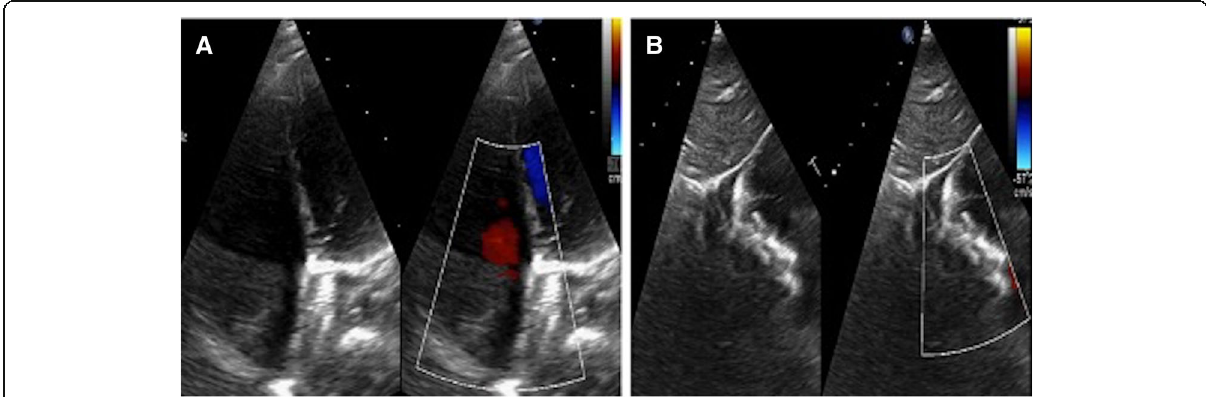
Fig. 8 Final transthoracic echocardiographic images confirming the proper positioning of the device across the interatrial septum in apical 4-chamber ( A ) and subcostal ( B )